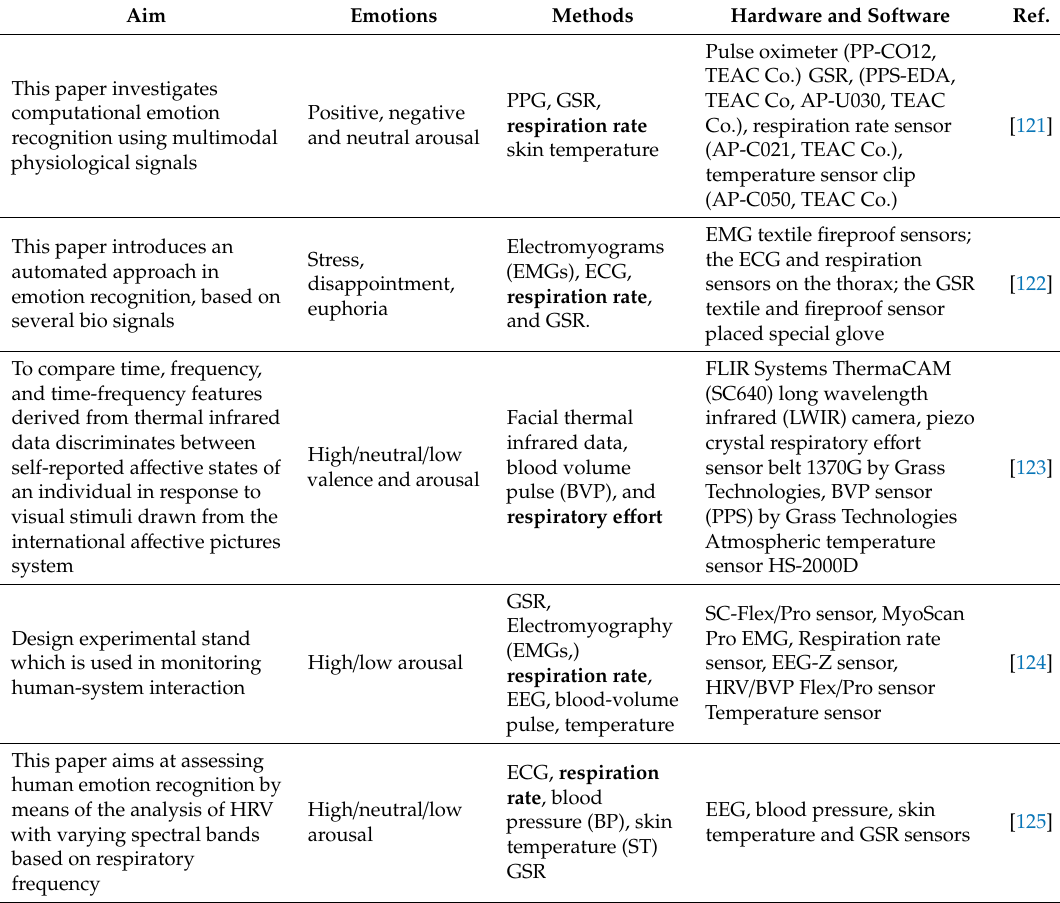
Table 7. Review of scientific researches focused on emotions recognition and evaluation using respiration rate